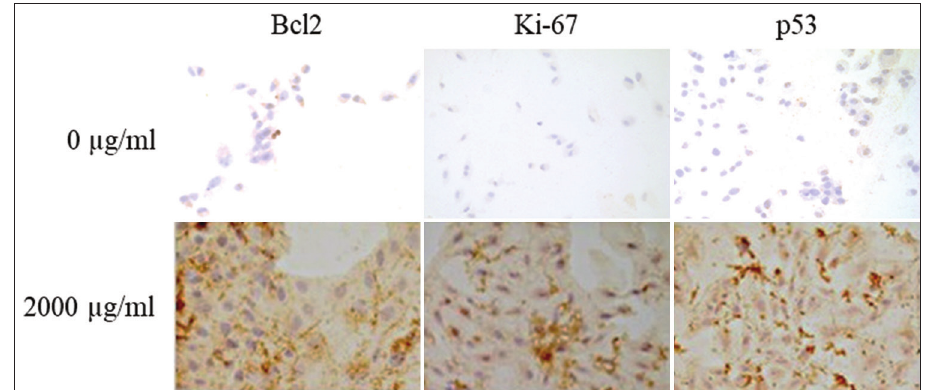
Figure-2: Photomicrographs of slides containing D-17 canine osteosarcoma cells, exposed to Jatobá leaf extract at a concentration of 2000 μ g/mL for 48 h, subjected to immunocytochemical assay by Bond-Max automated processor (Leica). Anti-Bcl2, anti-Ki-67, and anti-p53 antibodies. 3,3’-diaminobenzidine, hematoxylin counterstain. 62 μ m scale. Fields with positive stained cell ratio (RCCP) 3, EIE 1 and semi-quantitative combined scoring system (SPCS) 4, at 0 μ g/mL. Fields with RCCP 5, EIE 3, and SPCS 8, at 2000 μ Table-1: Evaluation of immunostaining in D-17 cells of canine osteosarcoma, exposed to crude EBFJ. Mean values were observed in the RCCP, the EIS, and the SPCS.